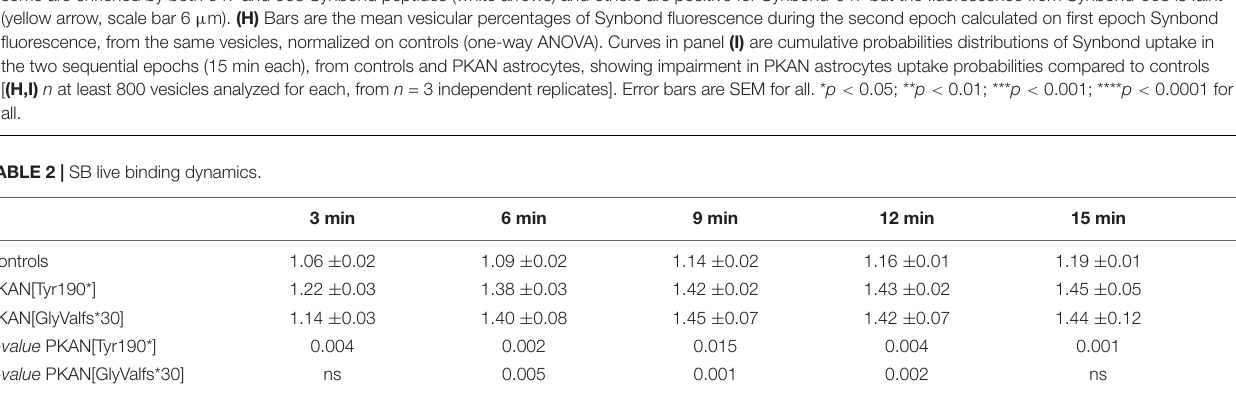
( Figure 2D ) is partially restored by CoA and 4-PBA